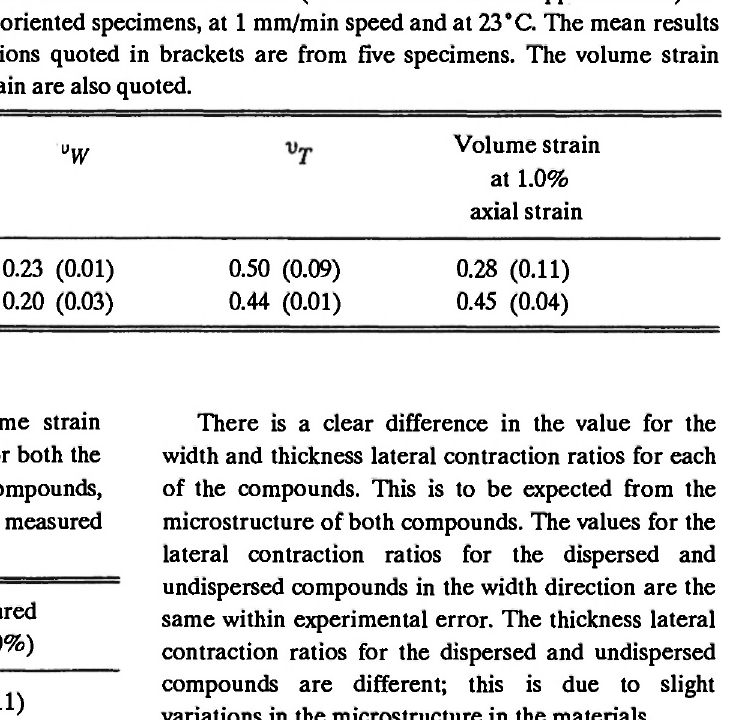
Table 8: Predicted versus measured volume strain response at 1.0% applied strain for both the "dispersed" and "undispersed" compounds, tested at the 90° orientation. The measured data is taken from Table